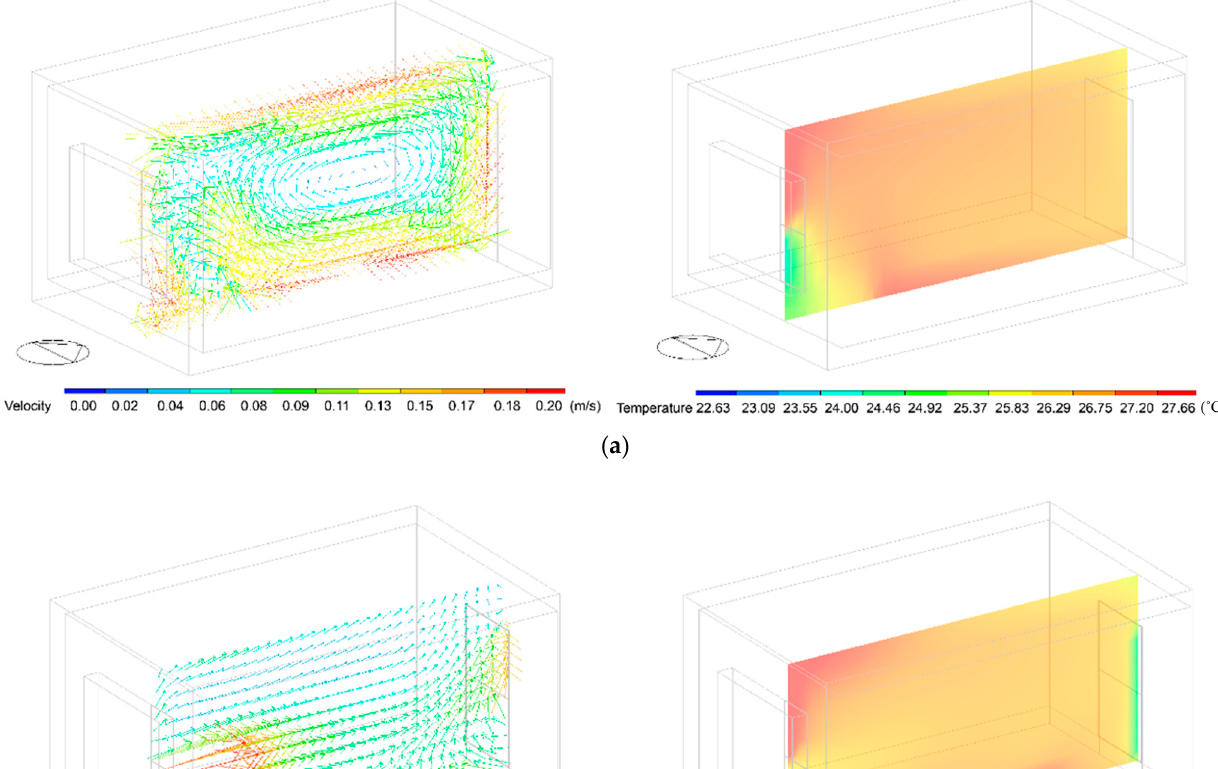
Figure 16. Validation of simulated and experimental indoor air velocity distribution for different wind directions.